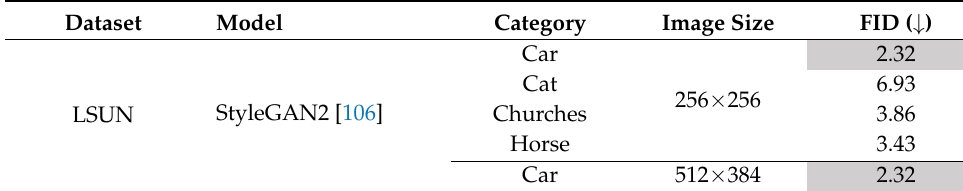
Table 13. FID of StyleGAN2 model trained with LSUN category and size-specific datasets. The lower the FID value, the better the performance.